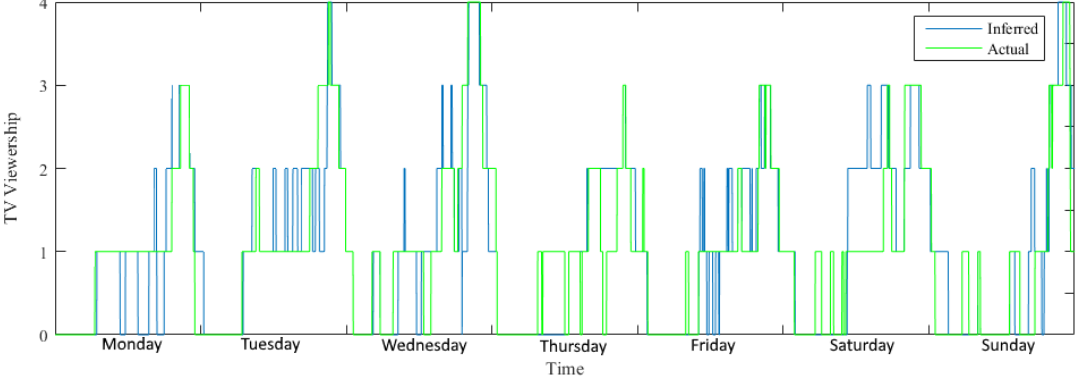
Figure 13. Viewership in week